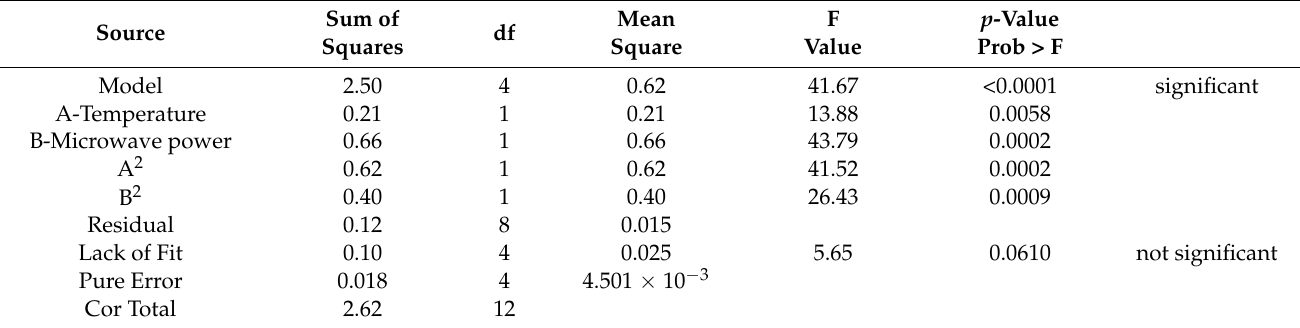
Table 13. Analysis of variance for vitamin C response using RSM.